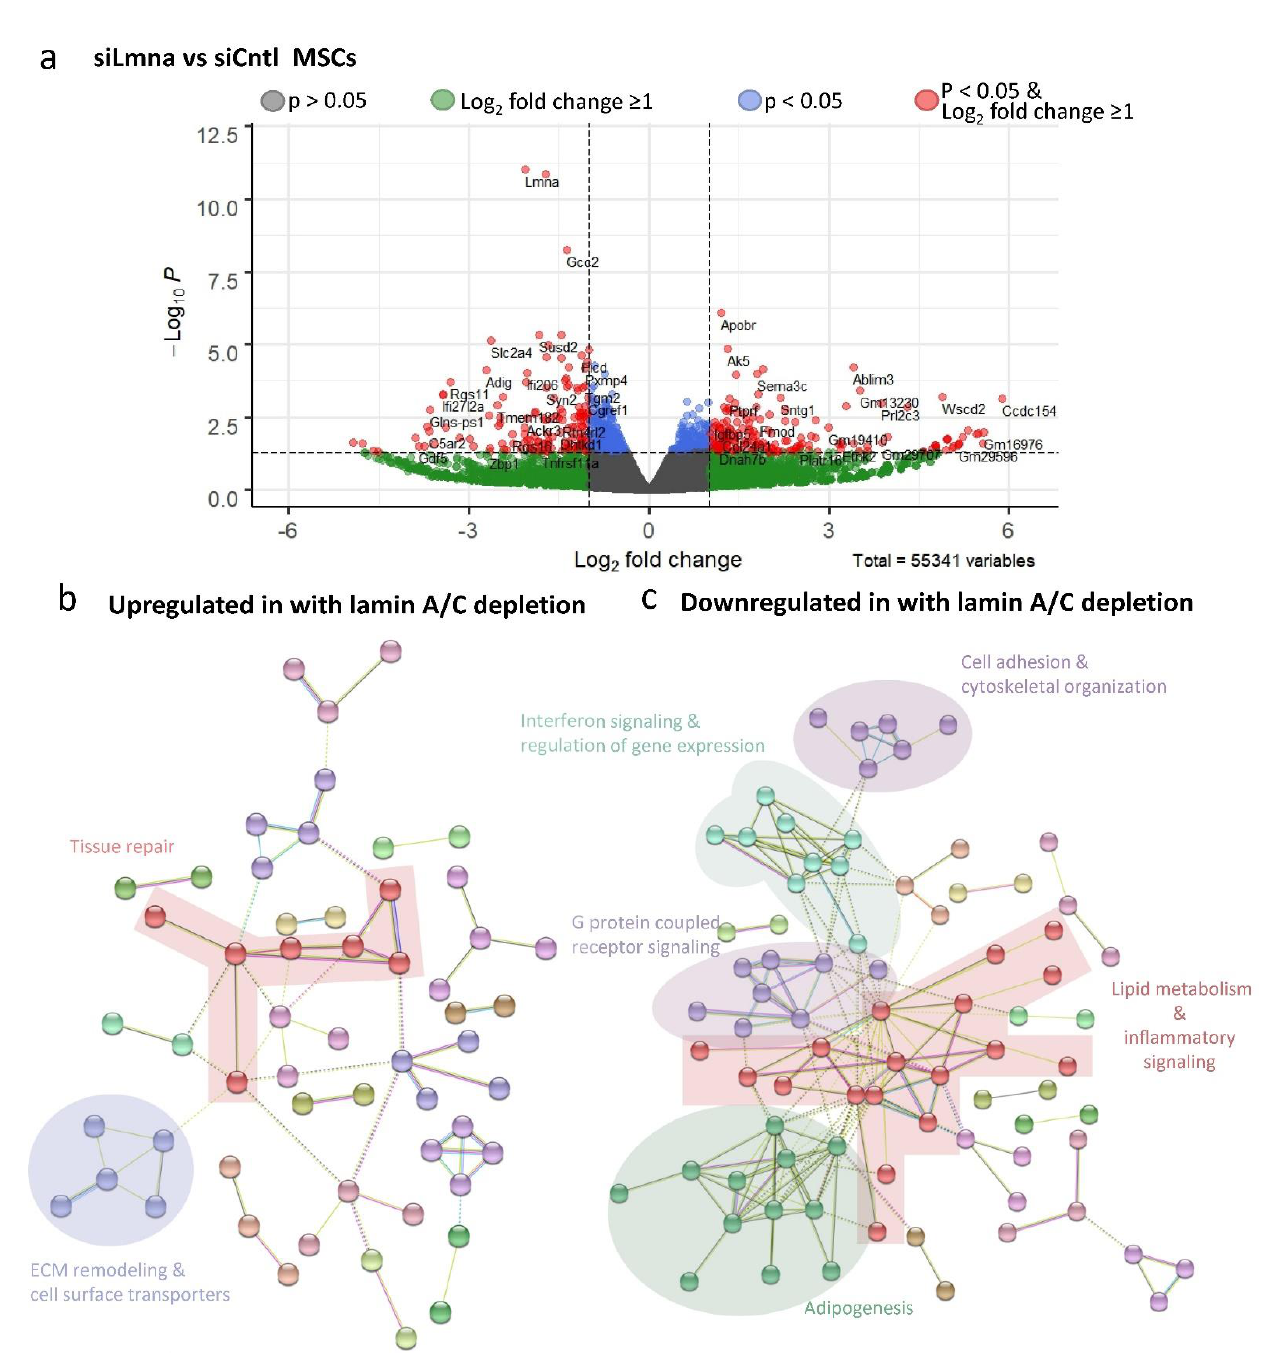
Figure 6. Lamin A/C depletion impedes adipogenic transcription in MSCs: ( a ) Volcano plot of siLmna compared to siCntl under adipogenic conditions. Genes with Wald values greater than p value of 0.05 are colored in grey. Genes with differential gene expression equal to or larger than 2-fold ( Log 2 = 1) but have Wald values greater than p value of 0.05 are colored in green. Genes colored with blue have Wald values smaller than p value of 0.05, but differential gene expression less than 2-fold ( Log 2 = 1). Genes with Wald values smaller than p value of 0.05 and differential gene expression equal to or larger than 2-fold ( Log 2 = 1) are colored in red. Grouping of five or more associated genes were highlighted and subsequently subjected to a supervised analysis of biologic function. ( b ) Upregulated genes were associated with cellular processes included tissue repair, ECM remodeling and cell surface transporters. ( c ) Downregulated gene groups included, cell adhesion and cytoskeletal organization, interferon signaling and regulation of gene expression, G-protein coupled receptor signaling, lipid metabolism and paracrine inflammatory signaling and adipogenic